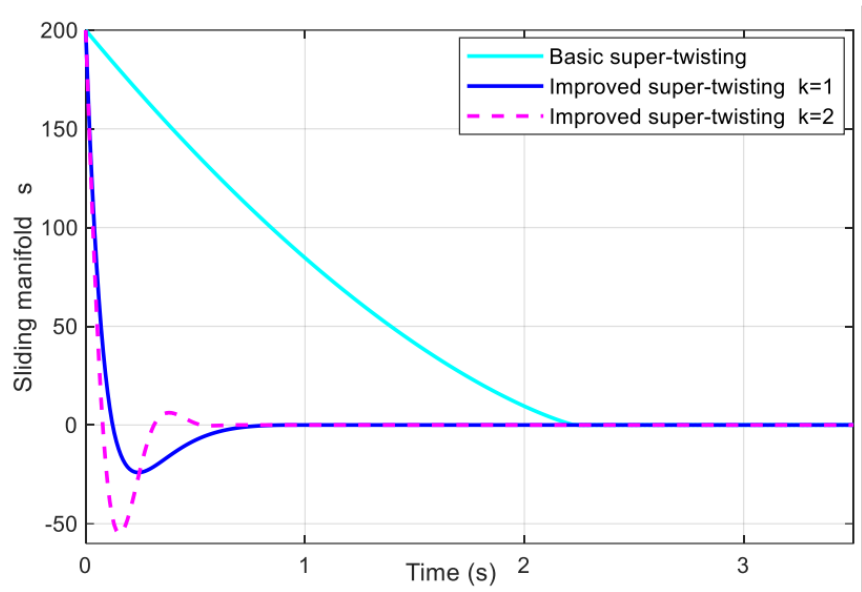
Figure 1. Convergence time comparison of different super-twisting